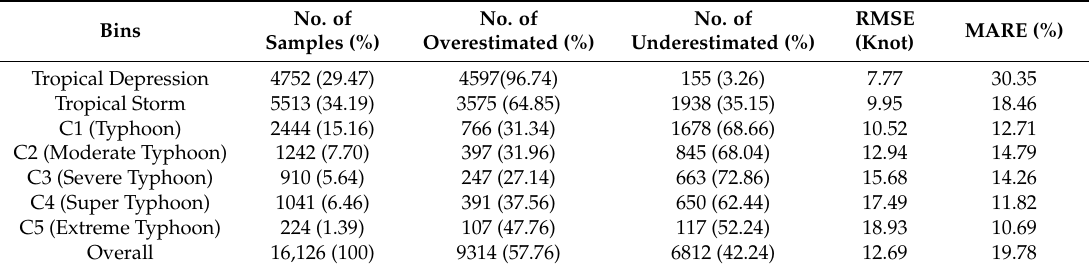
Table 4. Dependent tests of the model by dividing the cyclones into seven groups according to